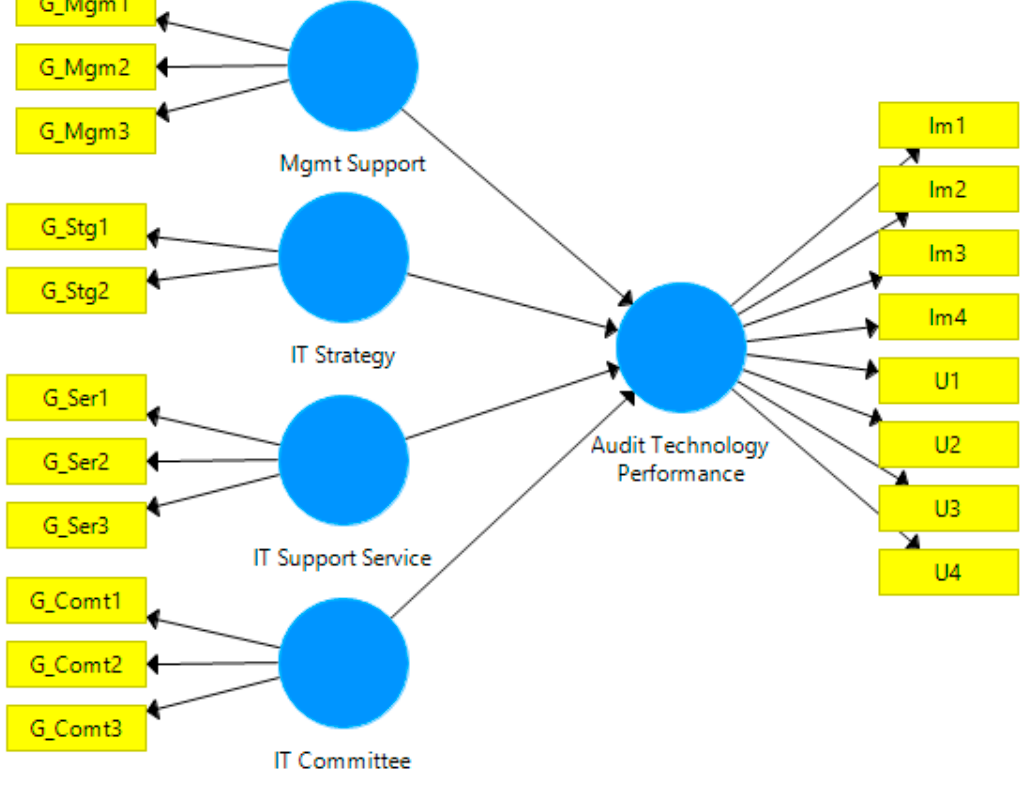
Figure 1. Research model of the study.